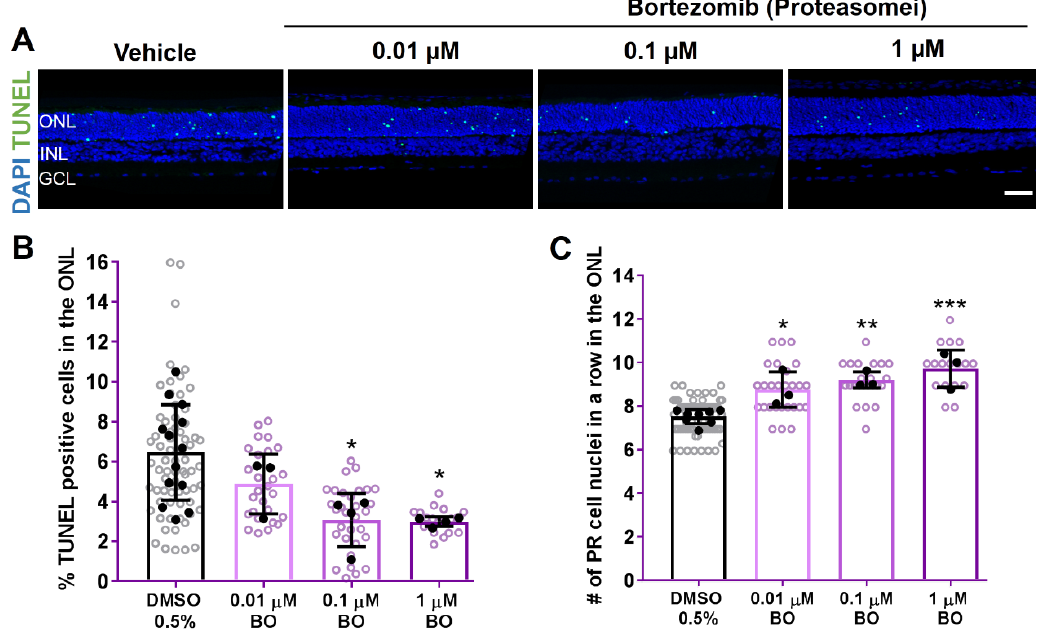
Figure 5. Proteasome inhibition by bortezomib (BO) enhances photoreceptor cell survival in RHO P23H rat retinae in vitro. Retinae from RHO P23H transgenic rats were explanted at postnatal day 9, cultivated for 6 days (PN9 DIV6), and treated every second day with different concentrations of the proteasome inhibitor BO. 0.5% DMSO was used as corresponding vehicle control. ( A ) Explants were stained with TUNEL assay to differentiate photoreceptors undergoing cell death (green) using nuclei counterstaining with DAPI (blue). ( B ) Bar chart shows the percentage of TUNEL-positive cells in the ONL. A significant decrease in the percentage of dying cells was observed after BO treatment. ( C ) Comparison of the number of remaining photoreceptor cell nuclei in a row in the ONL. Retinae treated with BO showed an increase in the number of photoreceptor cell rows. Scale bar is 50 µm. Values were quantified by scoring several images (open circles) from three retinae (closed circles, n = 3) per treatment for DMSO and 0.01 µM BO, and four retinae (n = 4) for 0.1 and 1 µM BO. The data are presented as mean ± SD, and one-way ANOVA analysis was performed. *** p < 0.001, ** p < 0.01, * p < 0.05. Proteasomei: Proteasome inhibitor; ONL: outer nuclear layer; INL: inner nuclear layer; GCL: ganglion cell layer; BO: bortezomib; DIV: days in vitro; PR: photoreceptor.